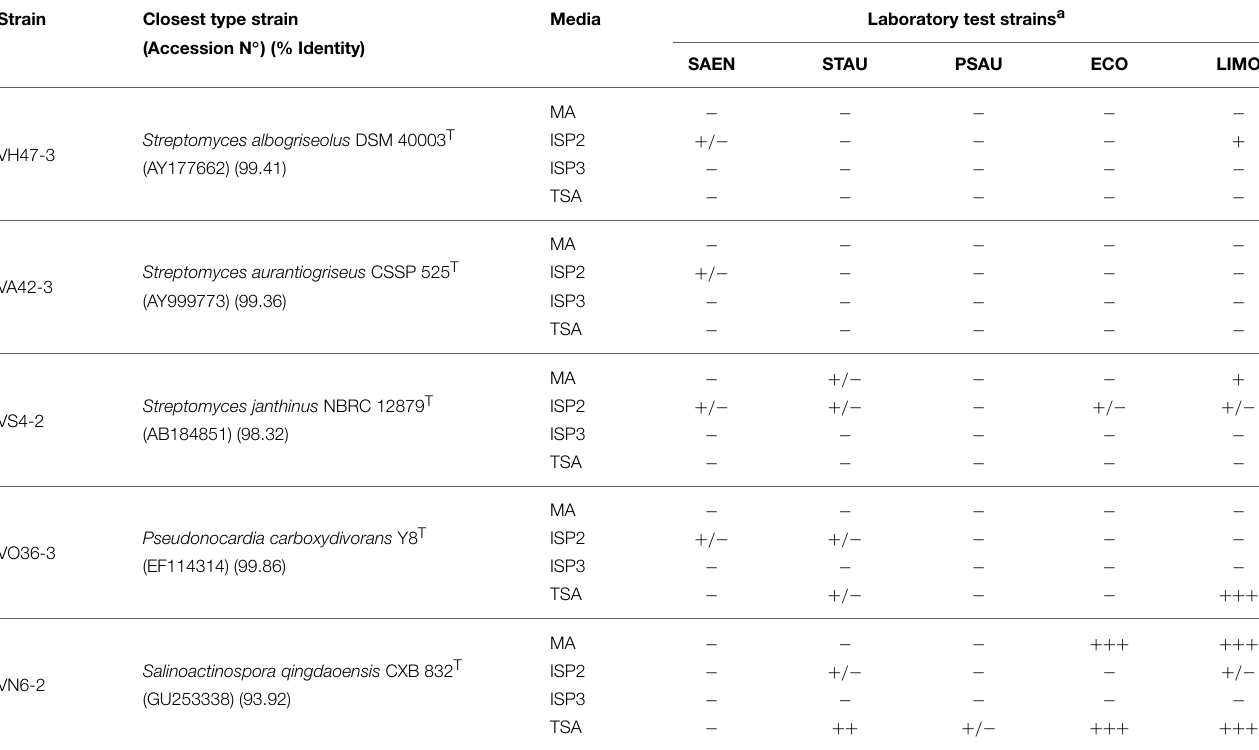
TABLE 1 | Antimicrobial activity of streptomycete-like strains. Strain Closest type strain